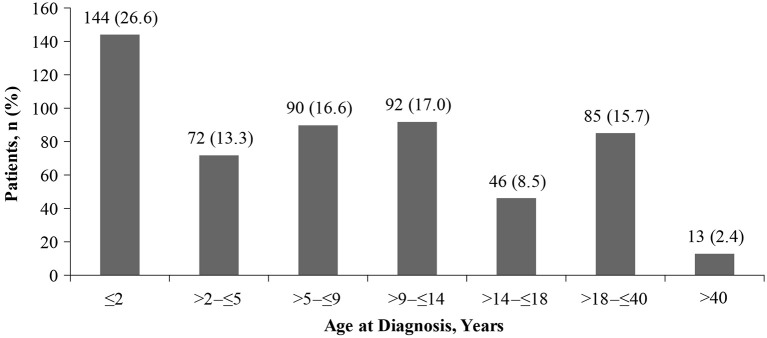
Proportion of patients with SEGAs according to age at SEGA diagnosis (n = 542).